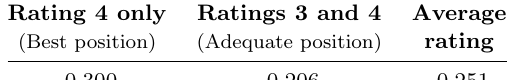
Table 4. The relationship between the wrist circum- ference and the system’s performance Rating 4 only Ratings 3 and 4 (Best position) (Adequate position)